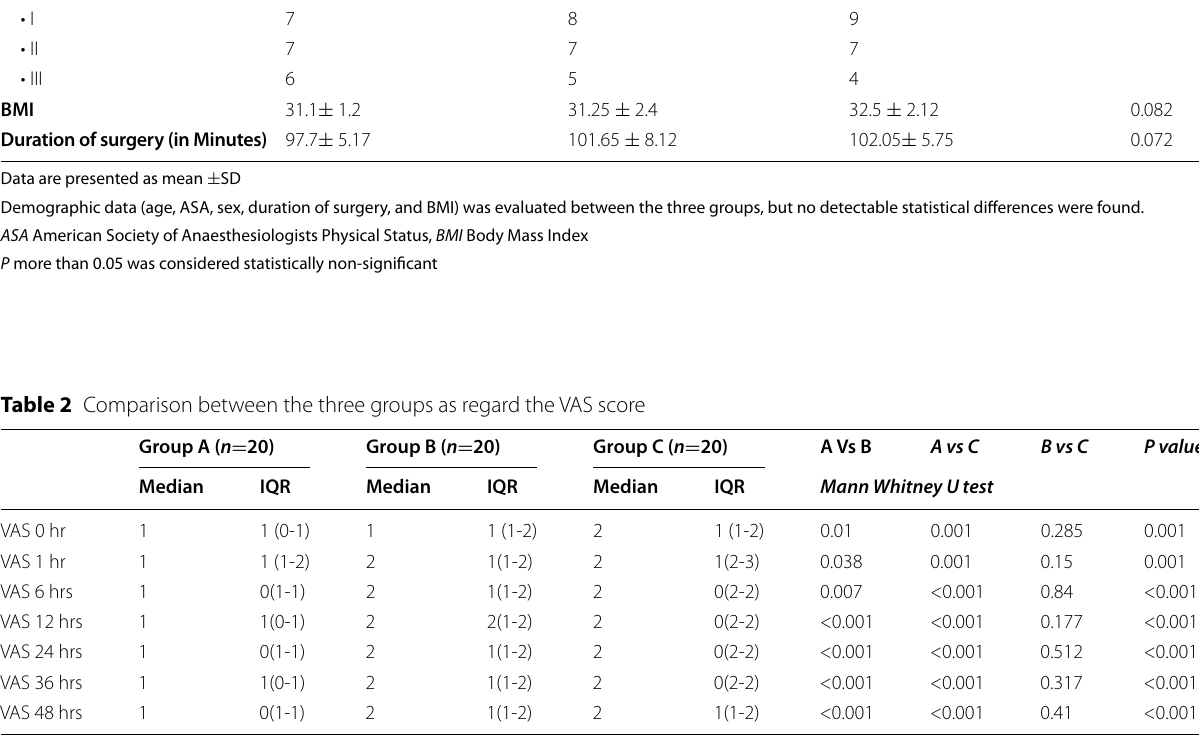
Data are presented as median SD ± VAS score was used to compare the three groups regarding postoperative pain control and was assessed at regular intervals (at PACU, 1hr,6hrs, 12hrs, 24hrs, 36hrs, and 48 hrs). The epidural group showed better pain control and lower VAS scores than both the femoral and adductor groups